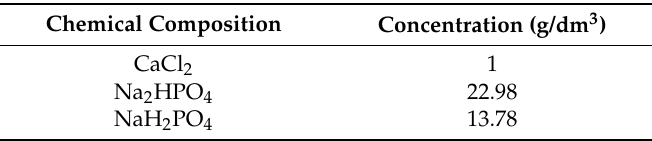
Table 2. Chemical composition of the synthetic